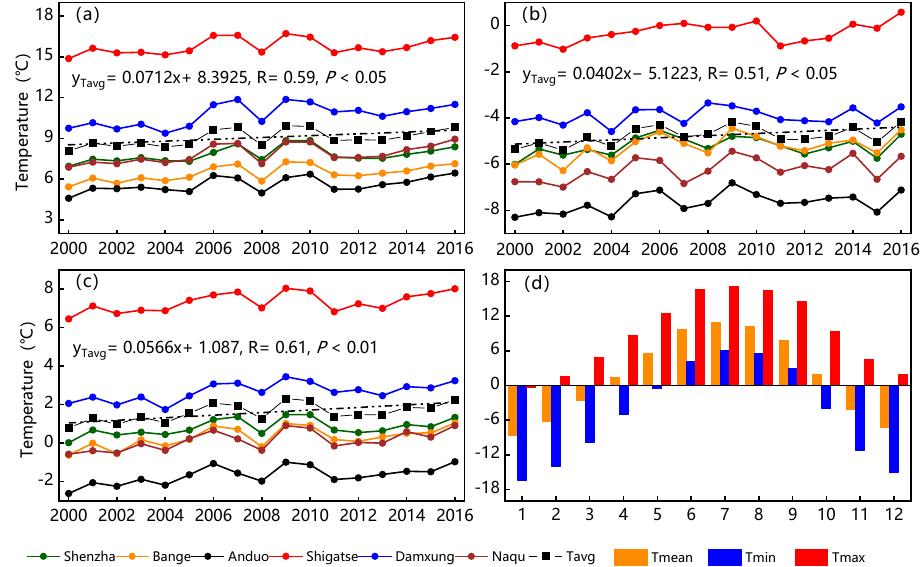
Figure 5. Temperature variation of meteorological stations in Siling Co. ( a ) Annual maximum temperature; ( b ) Annual minimum temperature; ( c ) Annual average temperature; ( d ) Monthly average temperature.